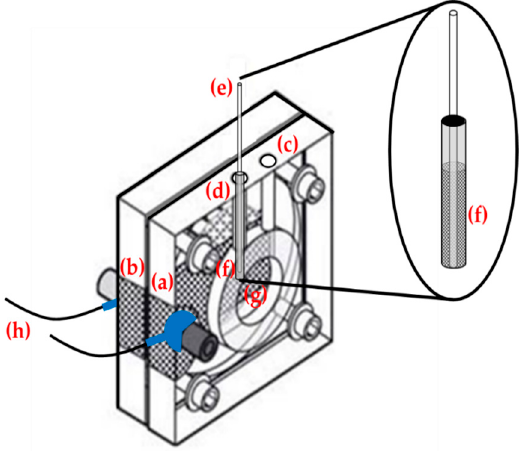
Figure 1. Schematic representation of the fuel cell used, where a small cylindrical dialysis membrane containing LDHs was inserted in the anodic section: ( a ) Anodic section of fuel cell. ( b ) Cathodic section of fuel cell. ( c ) Filling hole of the fuel cell with hydroalcoholic solution. Diameter 3.5 mm. ( d ) Hole containing the small cylindrical dialysis membrane (diameter of about 3.4 mm) containing LDHs, immersed 3 cm in the hydroalcoholic solution. ( e ) Holder of the cylindrical dialysis membrane with a diameter of approx. 2 mm. ( f ) Gap containing 63 mg of LDHs. ( g ) Cavity containing the two circular Pt-Ru electrodes, separated by a graphitized Na fi on membrane. ( h ) To Em-Stat potentiostat.